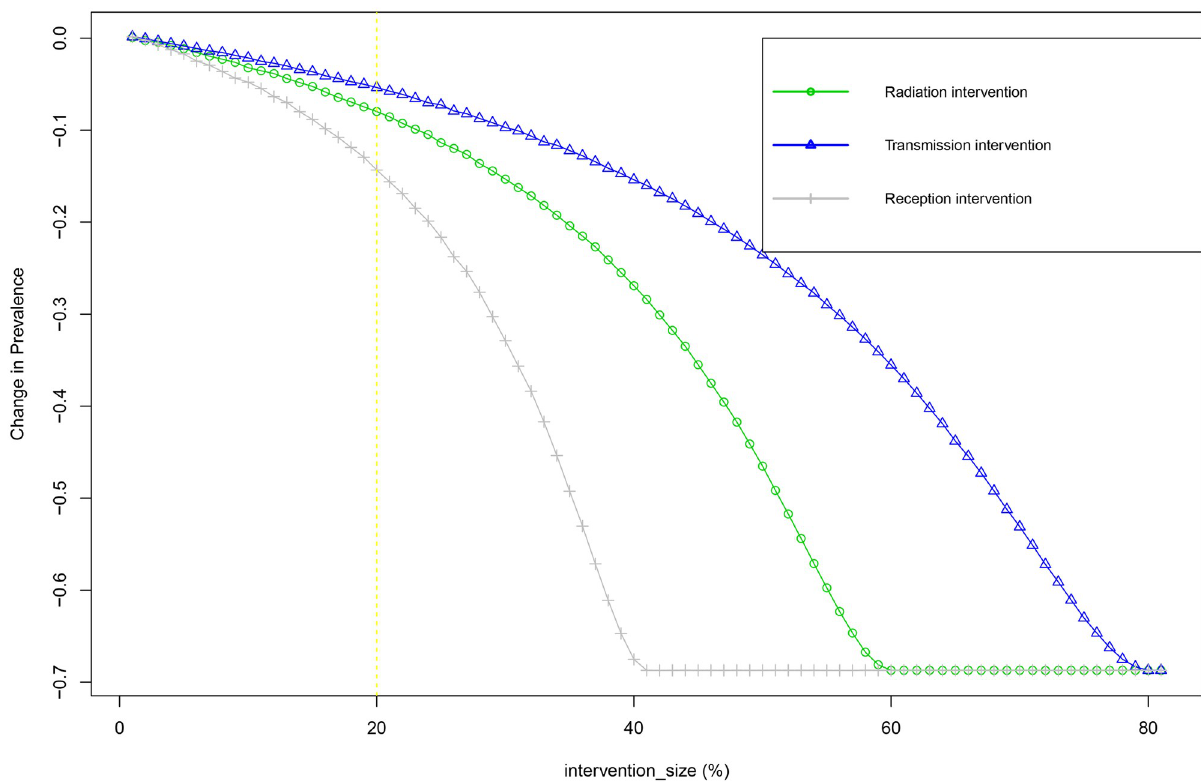
Fig 5. The mean reduction in prevalence (y-axis) in scenario 3 ( α = 0.8, ϕ = 0.4 and η = 0.6) for interventions of various size(x-axis) across the different target processes, green circles for interventions in Radiation ( α ), blue triangles for interventions in transmission ( ϕ ), and gray pluses for interventions in reception ( η